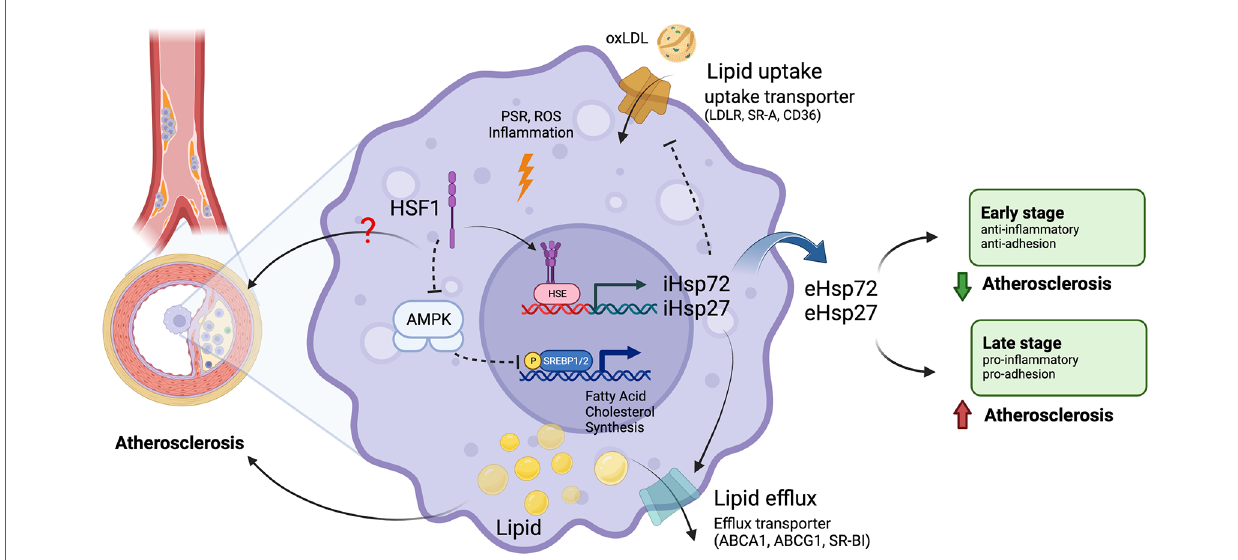
FIGURE 1 Roles of HSF1 in atherosclerosis. Macrophages uptake oxLDL through lipid uptake transporters and accumulate lipids intracellularly. Macrophages remove excessive intracellular lipids through lipid ef fl ux transporters. Unbalanced lipid homeostasis leads macrophages to form foam cells, leading to the formation of atherosclerosis plaques. Chronic in fl ammation, PSR, and ROS induce the transcriptional function of HSF1 to express HSPs, such as HSP27 and HSP72. Intercellular HSPs (iHSPs) promote cholesterol ef fl ux and inhibit lipid uptake. Secreted extracellular HSPs (eHSPs) play dual roles in atherosclerosis. HSPs inhibit atherogenesis during the early stage of atherosclerosis but promote atherosclerosis during the late stage of atherosclerosis. HSF1 non-transcriptionally promotes lipogenesis and cholesterol synthesis via SREBP1/2 by interacting with and inhibiting AMPK. ABCA1, ATP binding cassette subfamily A member 1; ABCG1, ATP binding cassette subfamily G member 1; AMPK, AMP-activated protein kinase; CD36, cluster of differentiation 36; eHSPs, extracellular heat shock proteins; HSE, heat shock element; HSF1, heat shock factor 1; HSPs, heat shock proteins; iHSPs, intracellular heat shock proteins; LDLR, low-density lipoprotein receptor; oxLDL, oxidized low-density lipoprotein; p, phosphorylation; PSR, proteotoxic stress response; ROS, reactive oxygen species; SR-A, scavenger receptor type A; SR-BI, scavenger receptor class B type I; SREBP1/2, sterol regulatory element binding protein 1/2. Images were created with